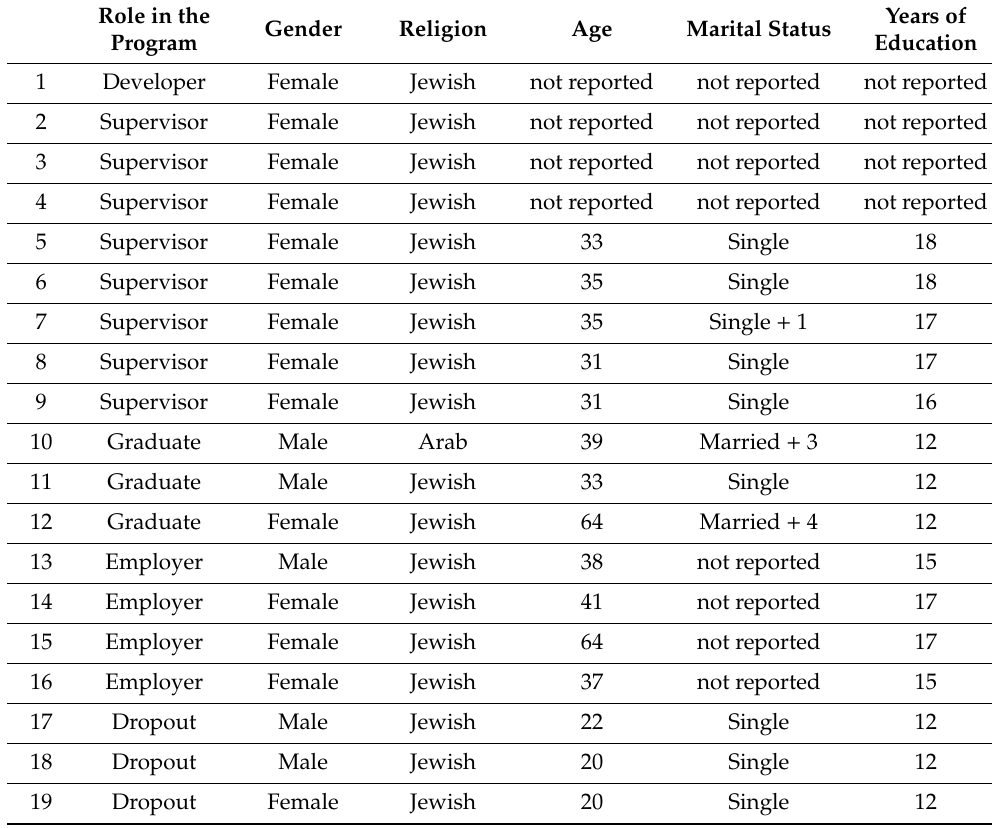
Table 1. Participants’